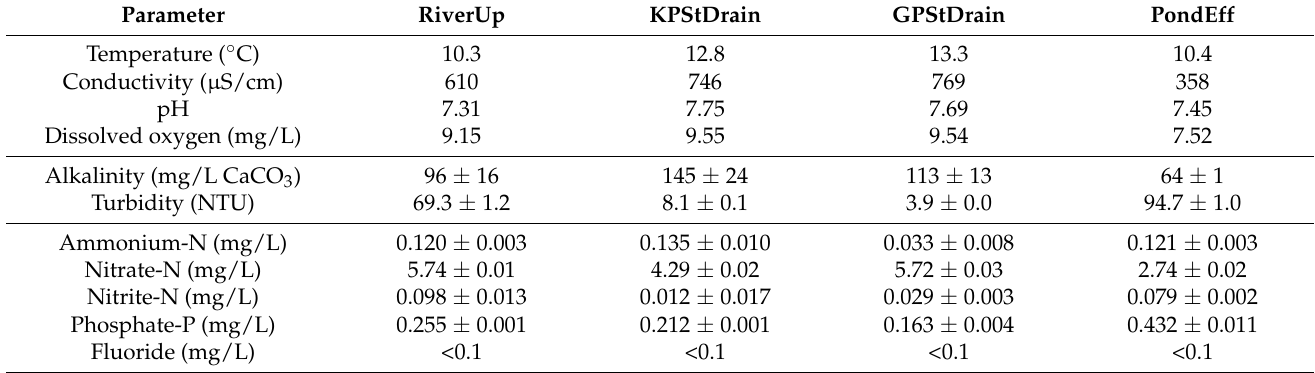
Table 4. Physicochemical metadata collected with the mobile laboratory. For the handheld probes, stabilized readings are reported. Errors are the average of duplicates for the other measurements.